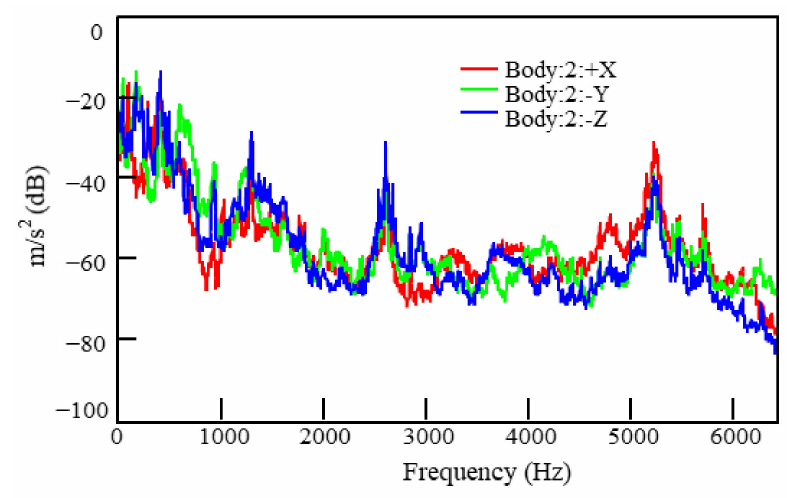
Figure 18. Excitation spectra on the front mount body (in three directions from Point 2).